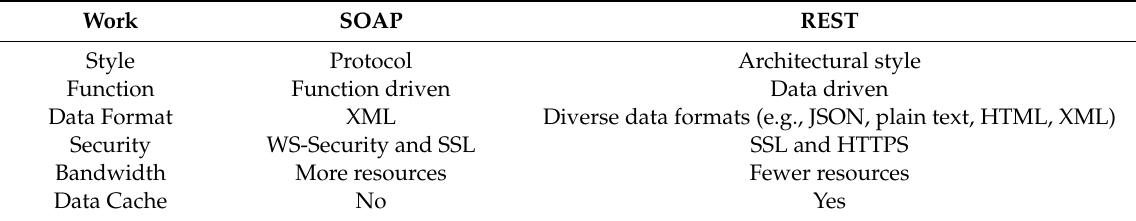
Table 2. SOAP web services vs. REST web